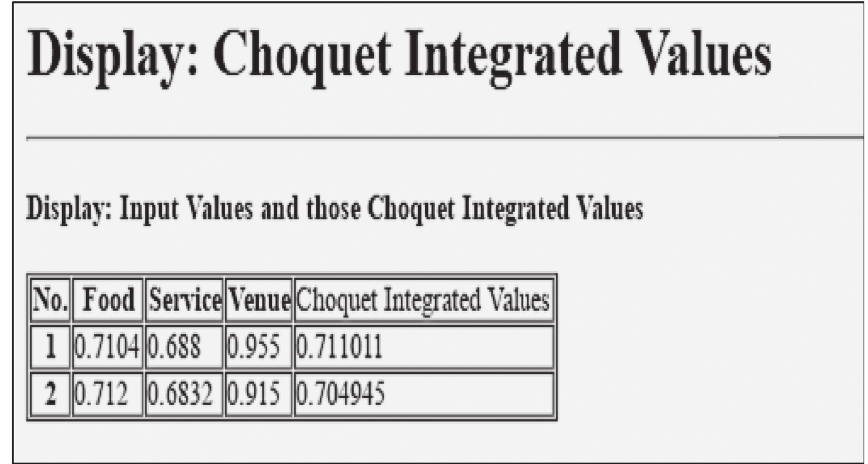
Figure 4: Choquet integrated values of two